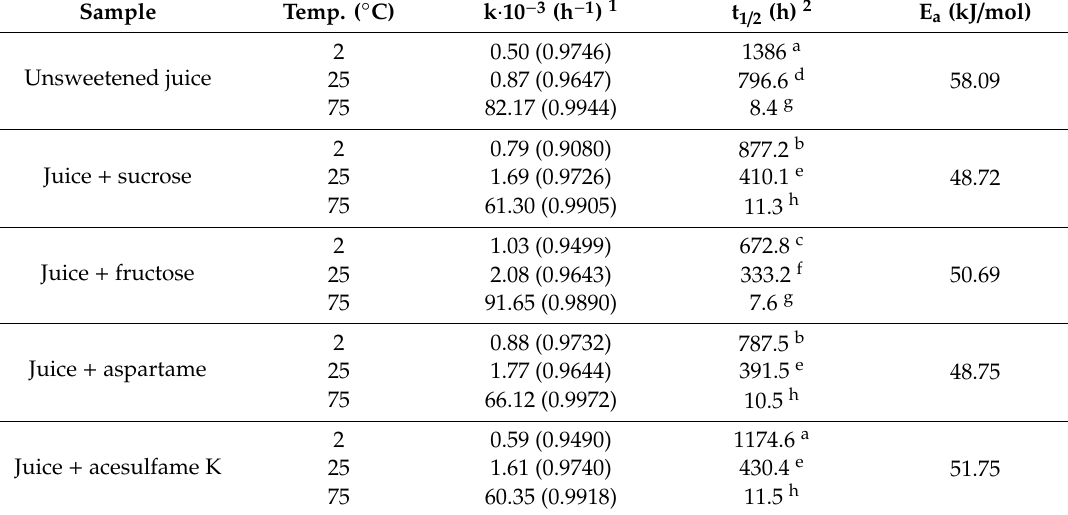
Table 1. Kinetic parameters of Cornelian cherry anthocyanins degradation in sweetened and unsweetened juice at different temperatures.